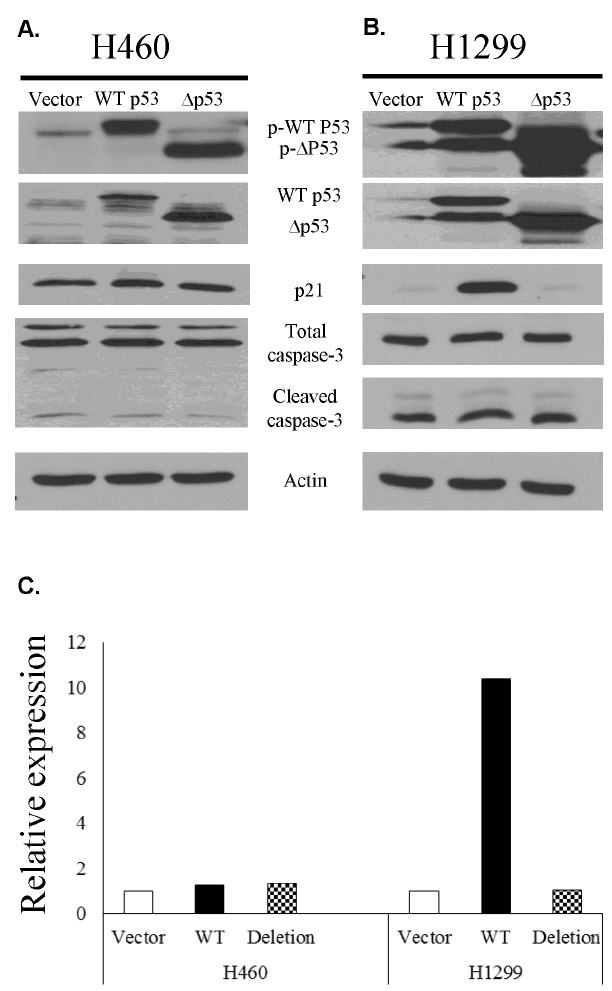
Figure 3. Overexpression of the novel mutant p53 does not induce p21 expression in p53-deficient H1299 cells. A. Overexpression of WT p53 or the deletion mutant in H460 cells resulted in higher expression of the truncated protein than the full length transcript; comparable levels of phosphorylated p53, p21, total caspase 3 and cleaved caspase 3 were observed. B. Overexpression of the same in H1299 cells resulted in similar protein expression patterns with the exception of p21, which was expressed as a result of transfection with WT p53 but not the deletion mutant. C. RT-PCR analysis confirms that similar levels of p21 are present in H460 cells transfected with the WT or mutated p53 and that H1299 cells transfected with WT p53 express much higher levels of p21 than those transfected with the mutant.